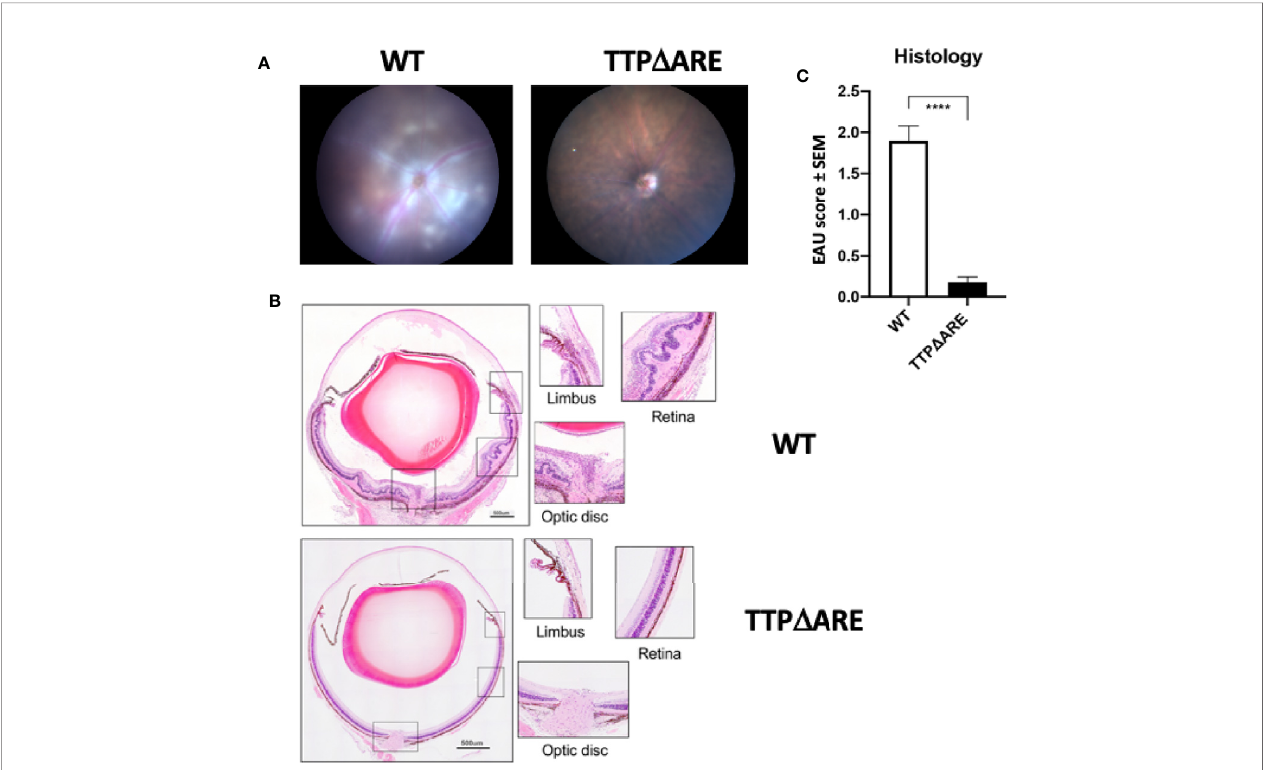
FIGURE 1 | Homozygous TTP D ARE mice are resistant to experimental autoimmune uveitis (EAU) development. Shown are (A) fundoscopic images (day 13 p.i.) and (B) histological images (day 14 p.i.) of eyes from homozygous TTP D ARE mice and their WT controls. The fundoscopic changes in the TTP D ARE mouse include vascular leakage due to in fl ammation, while the histological changes include retinal folding with accumulation of serous and cellular exudates in the subretinal space. The typical histological EAU changes also include in fl ammatory cell in fi ltration throughout the retinal layers, as well as accumulation of cells in the vitreous, optic nerve head and limbus. (C) summarizes the quantitative histological data from four separate experiments, with a total of 22 mice in each group. Mann-Whitney test was used,